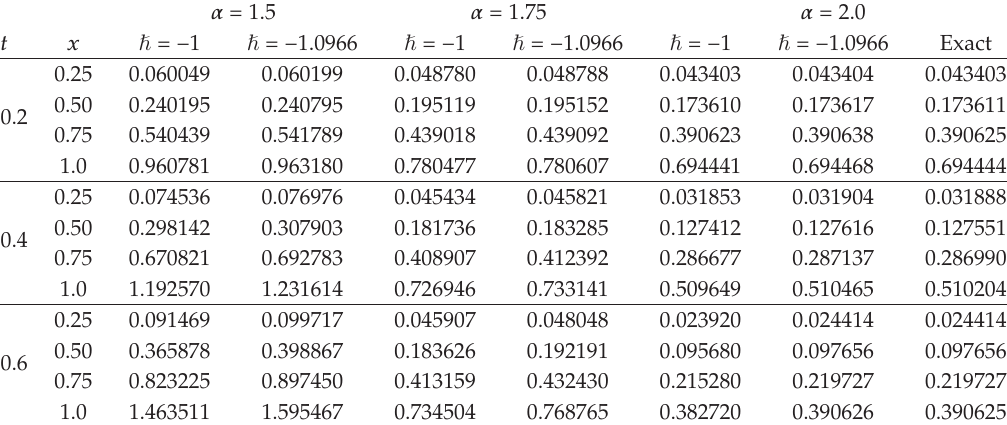
Table 2: Approximate solution of (cid:3) 4.14 (cid:4) for some values of α using the 4-term HAM approximation, φ with (cid:2) (cid:8) − 1 and (cid:2) (cid:8) − 1 . 0966.